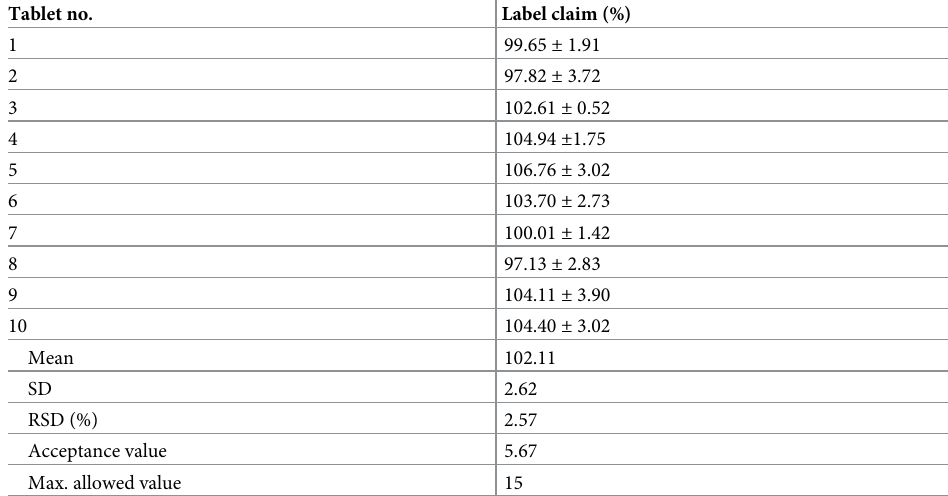
Table 6. Content uniformity testing of Tykerb 1 tablets using the micellar-enhanced spectrofluorimetric method. Tablet no.